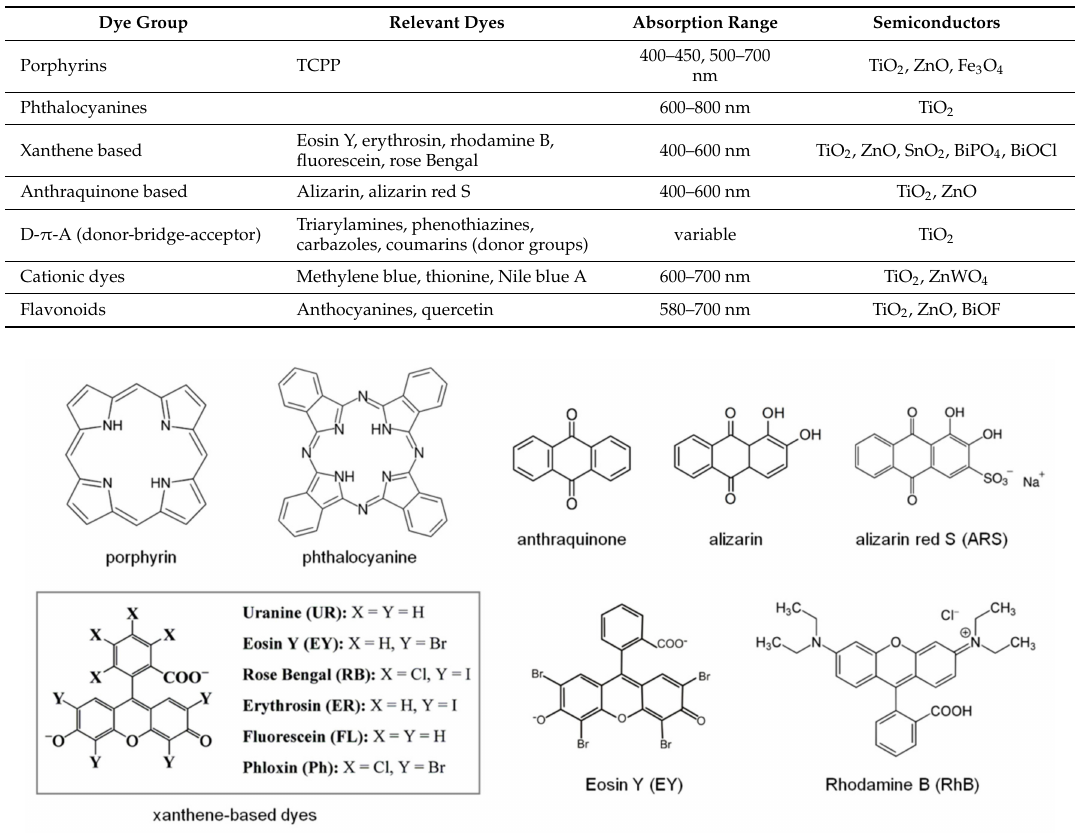
Table 1. Principal groups of organic dyes used in photosensitization, some relevant members, relative radiation absorption range, and the semiconductors coupled to them reported in this review.